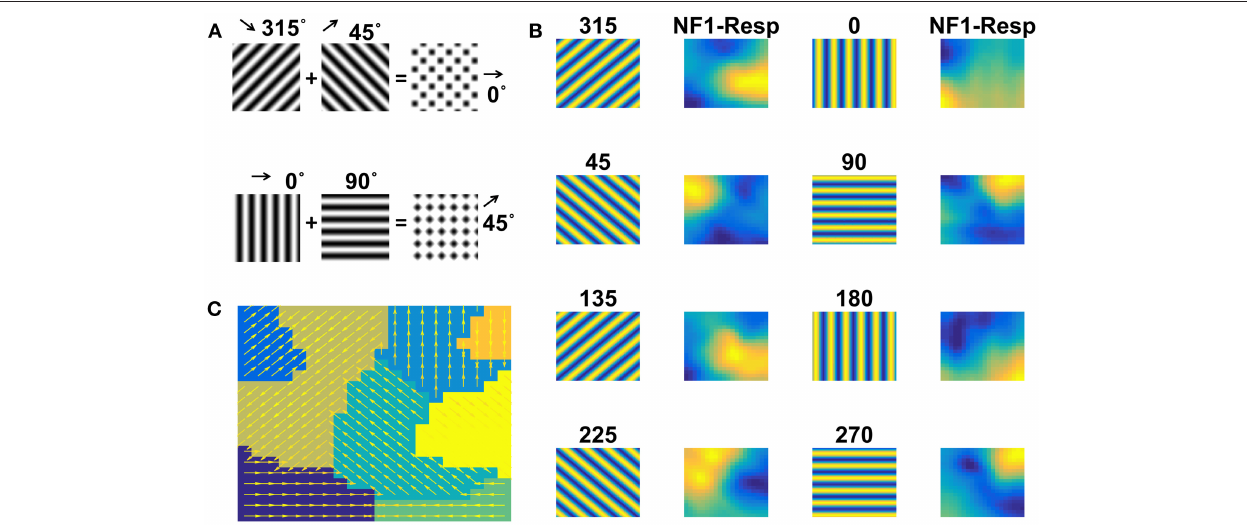
FIGURE 6 | NF1 response to moving grating stimuli. Grating stimulus consists of alternating black and white bars. Gratings (64 × 64 pixels) are moved in 8 different directions such that the direction of motion is orthogonal to the grating orientation. Plaid stimulus moving in 0 ◦ is created by superimposing two gratings moving in 45 ◦ and 135 ◦ as shown in (A) . NF1 (20 × 20 units) is trained with moving grating stimuli for 1,500 epochs and the response is plotted as shown in (B) . Here the first and third columns display the frames of moving grating. The label above it indicates the direction of motion of the grating. The second and the fourth columns represent the neuronal preferences to a given grating. As seen in other simulations, different neuron patches become active to different motion directions. Also, component selectivity map is shown in (C) . The arrows indicate the neuron preferred directions of motion.